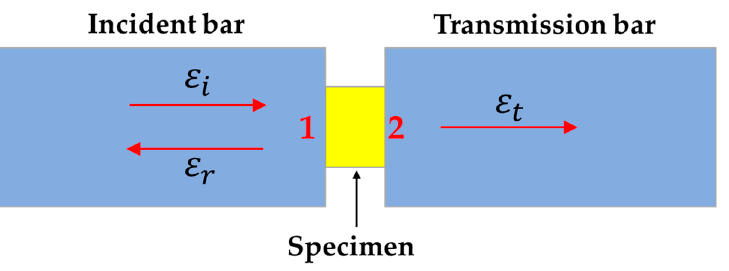
Figure 7. The structural diagram of the local interaction between the test sample and the SHPB pressure bar.